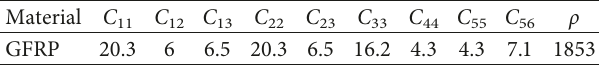
Table 1: Elastic constants in GPa and mass density in Kg/m 3 .